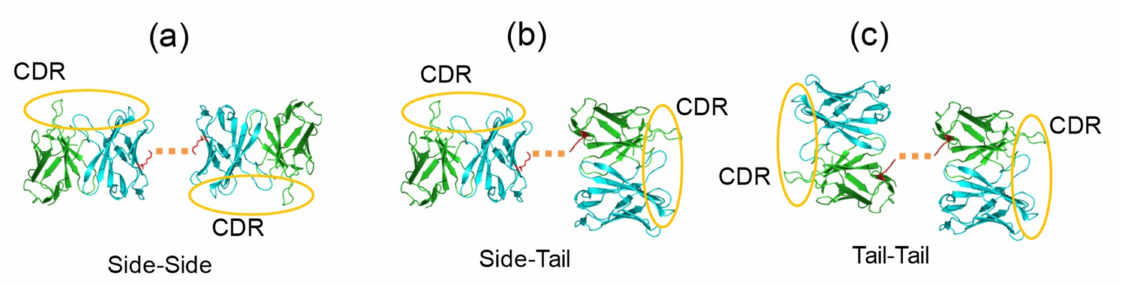
Figure 5. Chemically crosslinked bivalent h528 scFv dimers (VH: light blue, VL: green) with ( a ) two